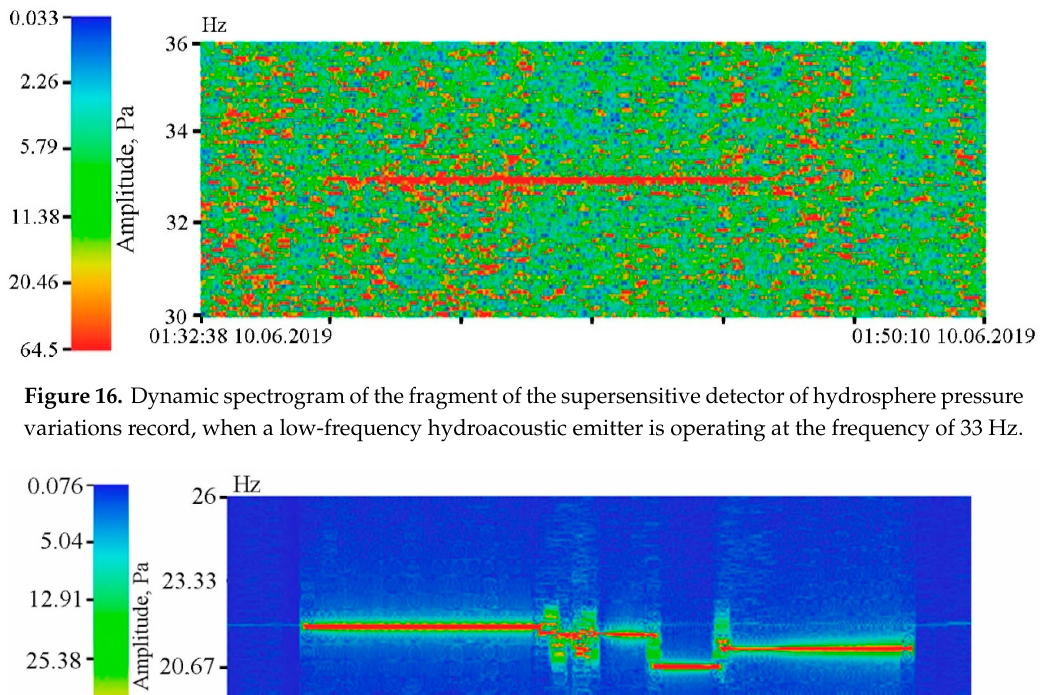
Figure 14. Dynamic spectrogram of the record of the supersensitive detector of hydrosphere pressure variations, obtained in the process of recording signals of various complexity, generated by a low-frequency hydroacoustic emitter with carrier frequency of 245 Hz. Figure 15. Experiment schematic. SSDHPV—supersensitive detector of hydrosphere pressure